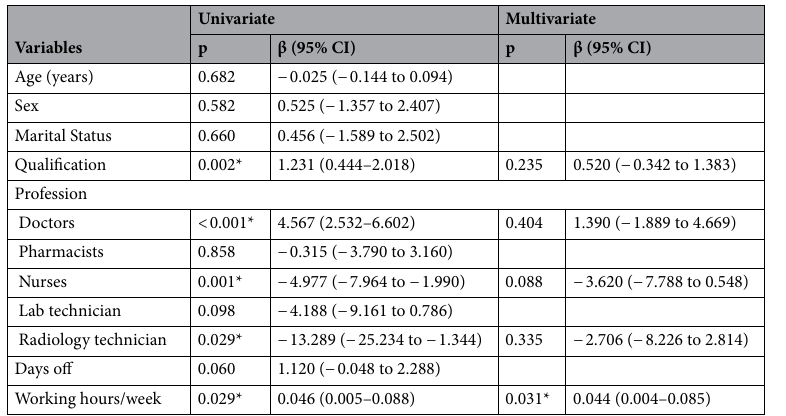
Predictors of burnout syndrome. The analysis of factors affecting burnout was contextualized to each different setting using univariate and multivariate regression models. Table 3 shows that, among Egyptian HCPs, the independent parameters from the sociodemographic and work-related characteristics that affected the burn- out syndrome from the univariate regression analysis with statistical significance were educational qualifications (β = 1.231, p = 0.002), certain professions as doctors (β = 4.567, p ≤ 0.001), nurses (β = 4.977, p = 0.001), radiology technicians (β = 13.289, p = 0.029) and the working hours per week (β = 0.046, p = 0.029). However, after adjust- ing for all other independent variables the multivariate analysis showed that working hours were the only sig-